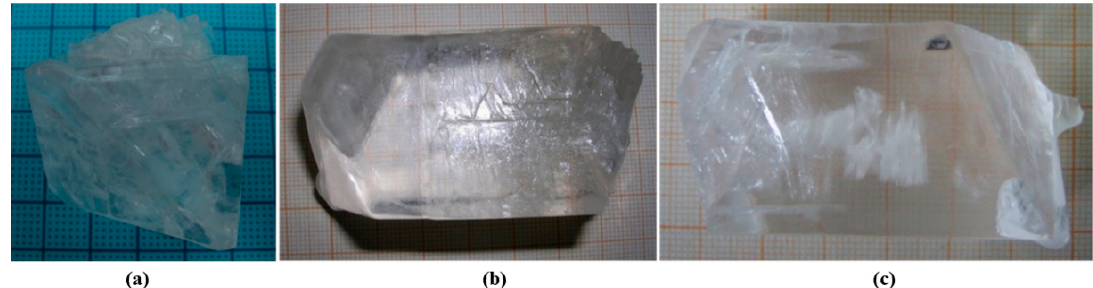
Figure 1. CBO crystals with ( a ) parallel groupings, ( b ) growth steps, and ( c ) inclusions.